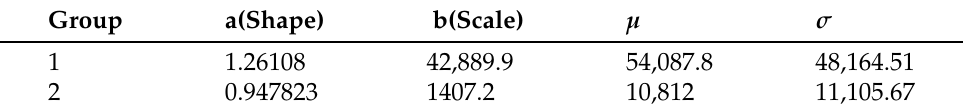
Table 14. Parameter Computation for Category D.